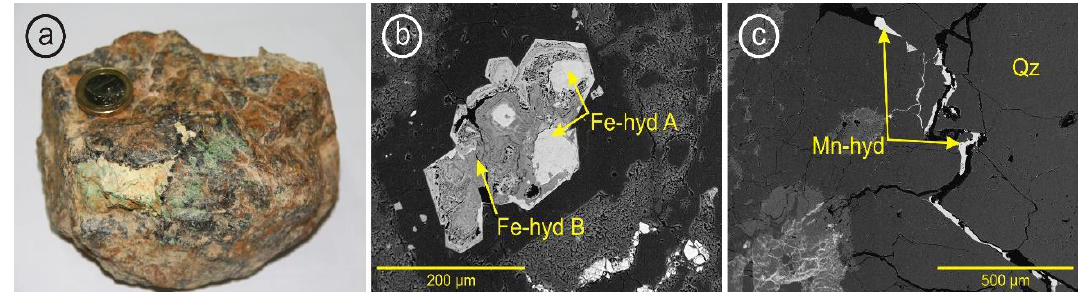
Figure 2. Mineralized quartz veins from Picoto mine: ( a ) Meta-torbernite (green mineral) and uranophane (yellow mineral); ( b ) Fe-hydroxides (Fe-hyd A and Fe-hyd B); ( c ) Mn-hydroxides (Mn-hyd) filling microfractures in quartz (Qz).